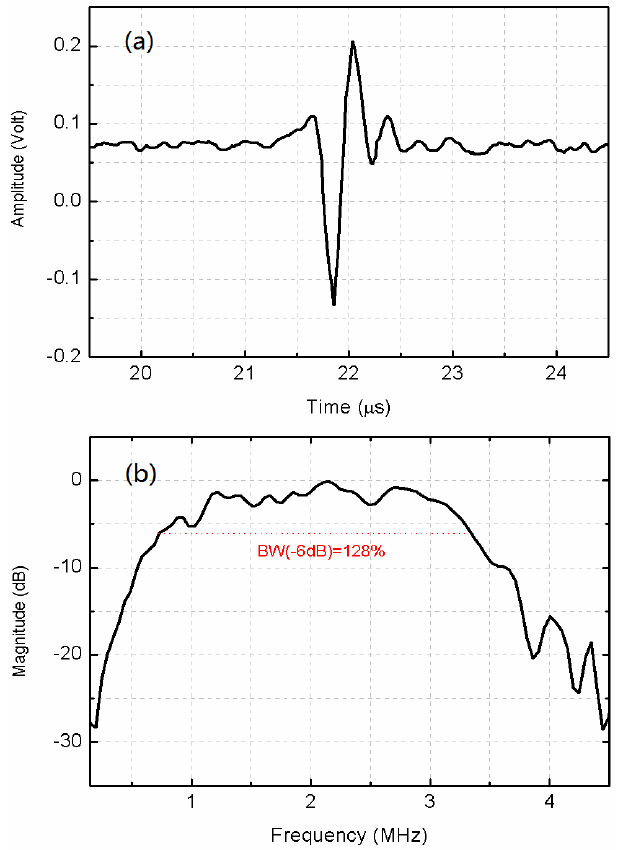
Figure 20. Pulse echo response and frequency spectrum of the cylindrically shaped linear array (with permission from